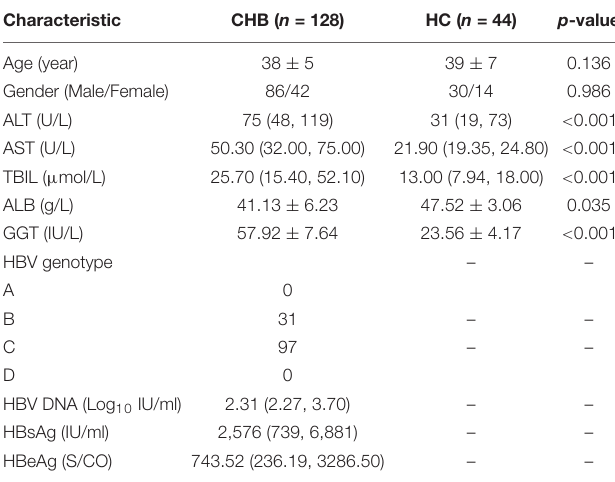
TABLE 1 | Baseline and laboratory data of patients with CHB and health controls